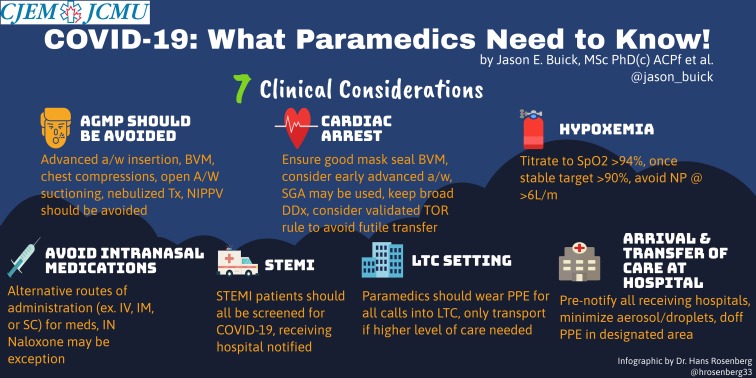
What Paramedics Need to Know infographic.